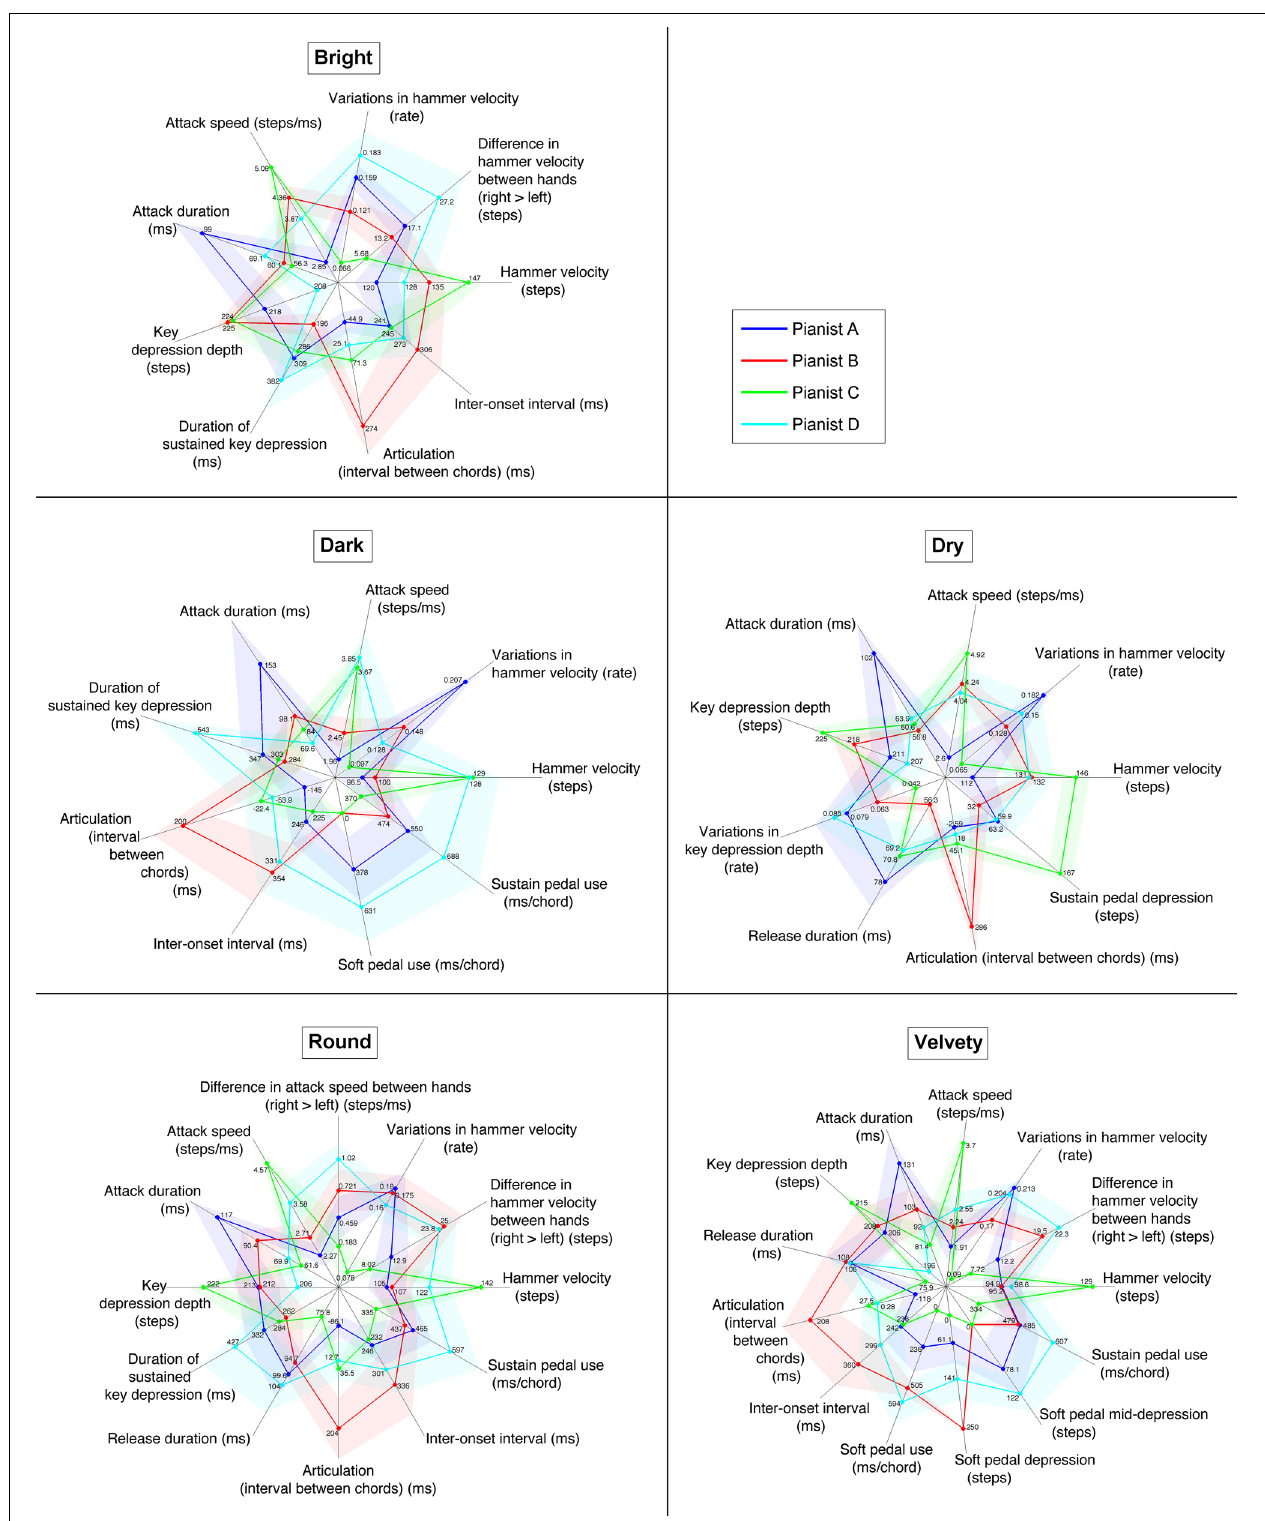
FIGURE 5 | Kiviats charts of the performance features giving a minimal and unique description of four pianists’ individual performance patterns in the production of each of five timbral nuances (bright, dark, dry, round, and velvety). Z-scores per pianist are plotted for each feature with